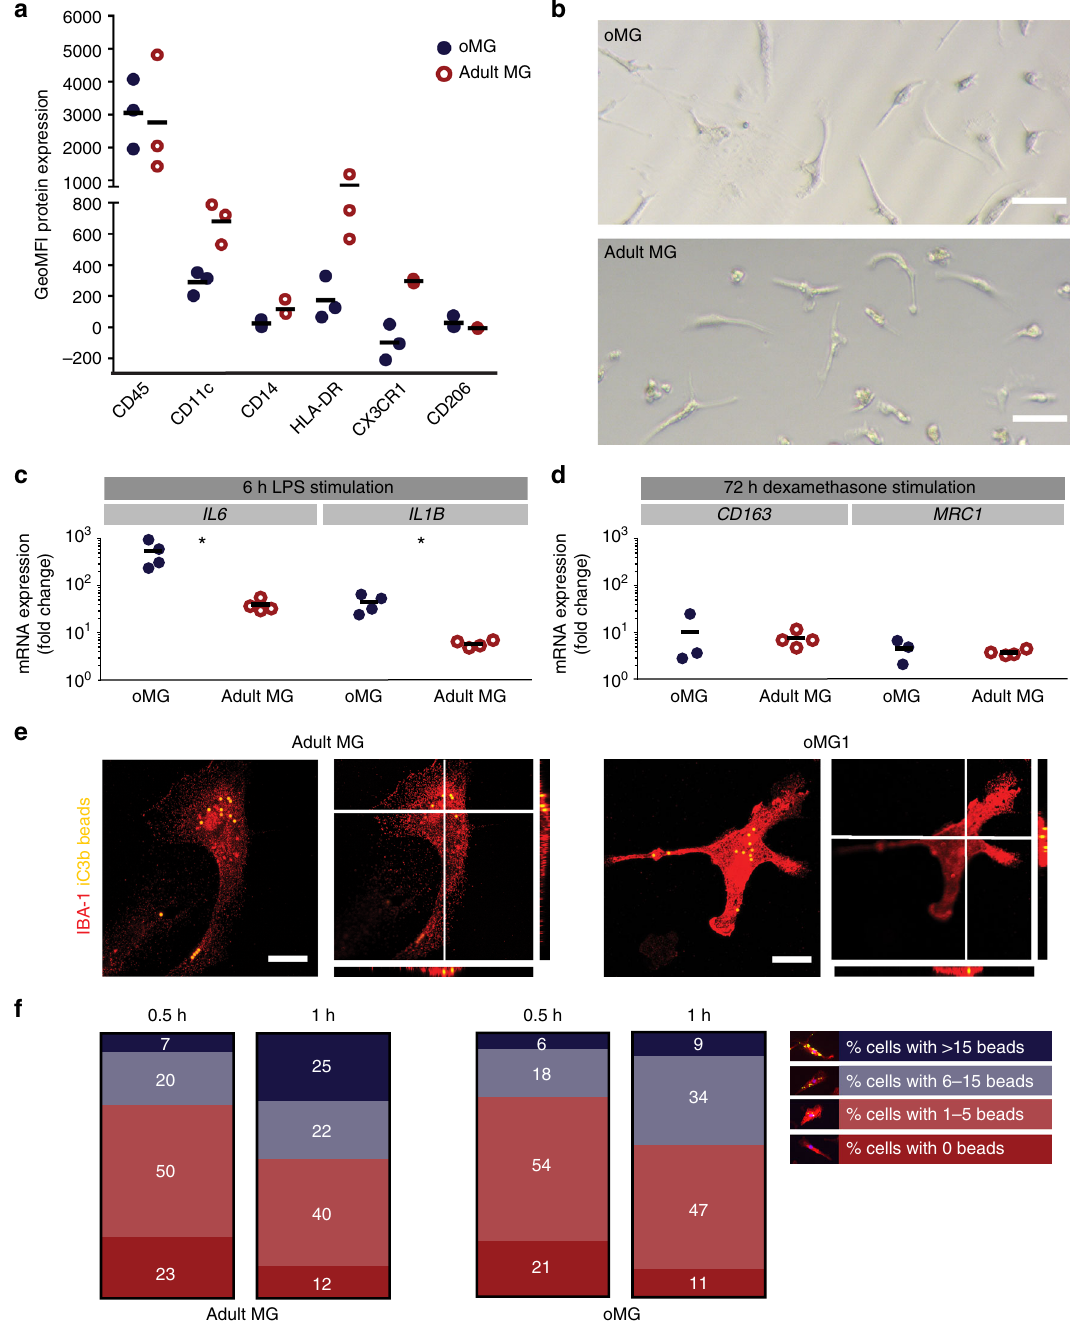
Fig. 4 oMG expressed microglia-characteristic cell surface markers and showed similar functional immune and phagocytic properties as adult MG. a Flow cytometric analyses of the expression pattern of microglial extracellular markers on CD11b + -gated oMG (oMG 1, 3, and 5) compared to adult MG derived from three separate brain regions from adult MG1.1. (eight organoids were pooled per donor (oMG 1, 3, and 5) after 52 days in culture). b Morphology of magnetic automated cell sorted CD11b + oMG 1 and adult MG in bright fi eld microscope after 1 week in culture. Scale bar 40 μ m. c mRNA expression, determined by qRT-PCR, of pro-in fl ammatory cytokines IL6 and IL1B after 6 h stimulation with LPS was signi fi cantly higher in oMG compared to adult